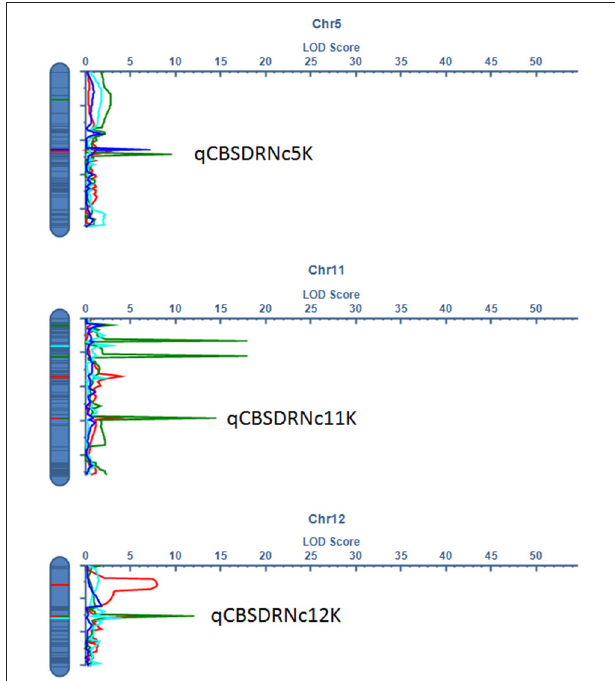
FIGURE 3 | LOD profile for stable QTL associated with CBSD root necrosis at qCBSDRNc5K at C2 (green), N1 (red), and N2 (blue), root necrosis and foliar symptoms at qCBSDRNFc11K at N1 (red) and N2 (green), and root necrosis only at qCBSDRNc12K at C1 (sky blue), N1 (red), and N2 (green) detected on chromosomes V, XI, and XII, respectively.